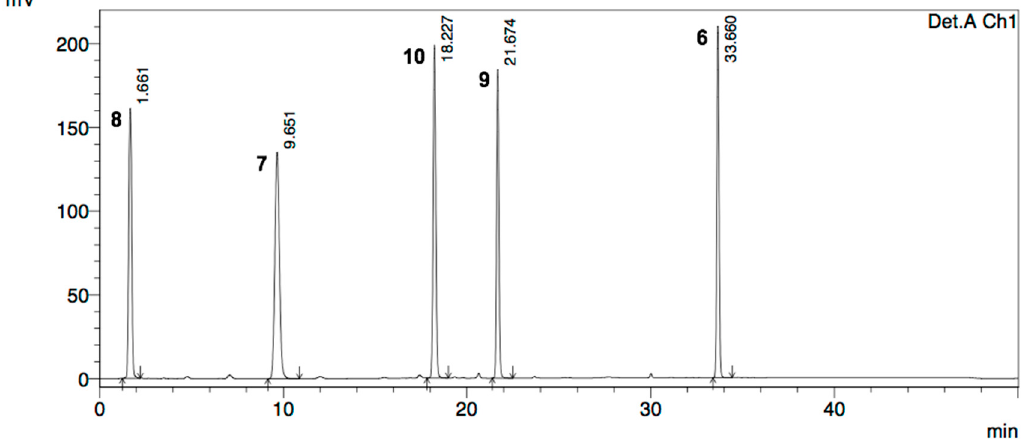
Figure 5. Chromatogram of a reference standard solution containing OM ( 7 ) and the impurities 6 , 8 , 9 , and 10 at the concentration of 0.1 mg/mL.